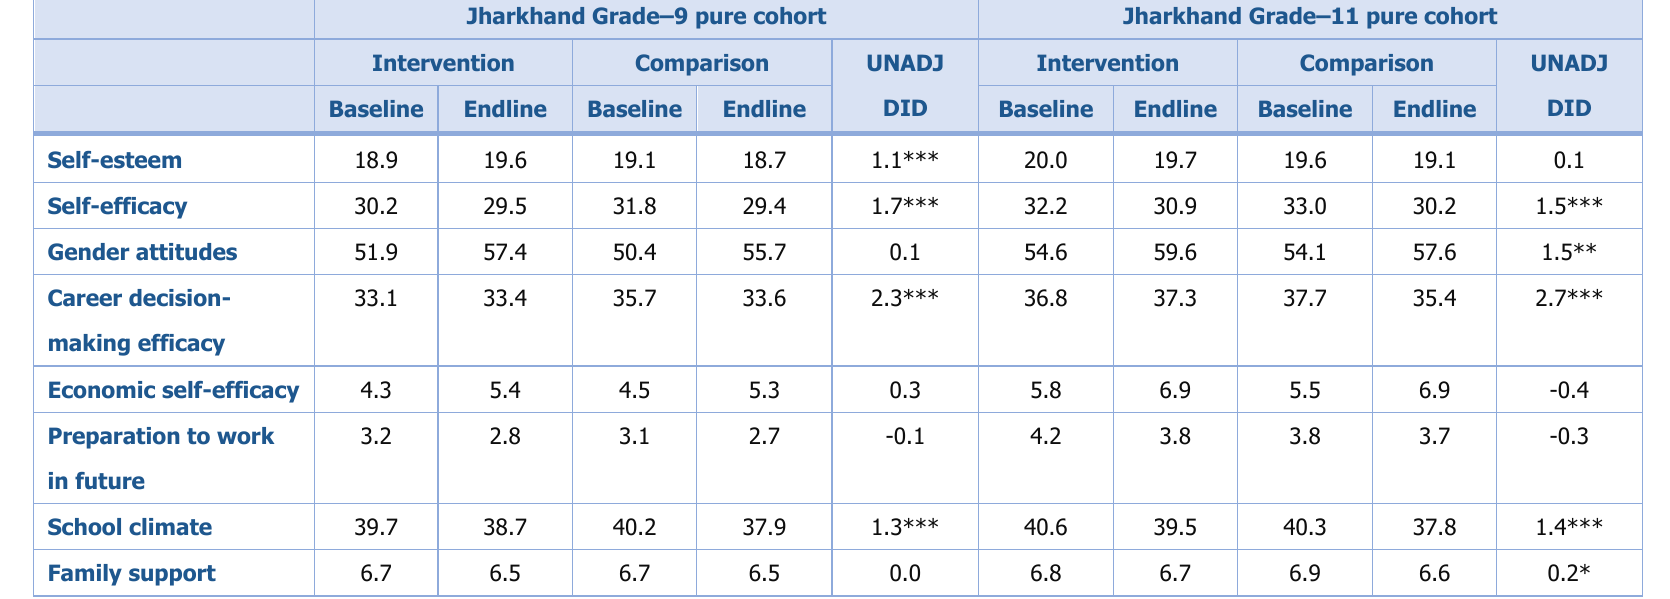
Table 4. Mean Scores of Empowerment and Employability Outcome Variables Over Time Across Comparison and Intervention Schools and DID in